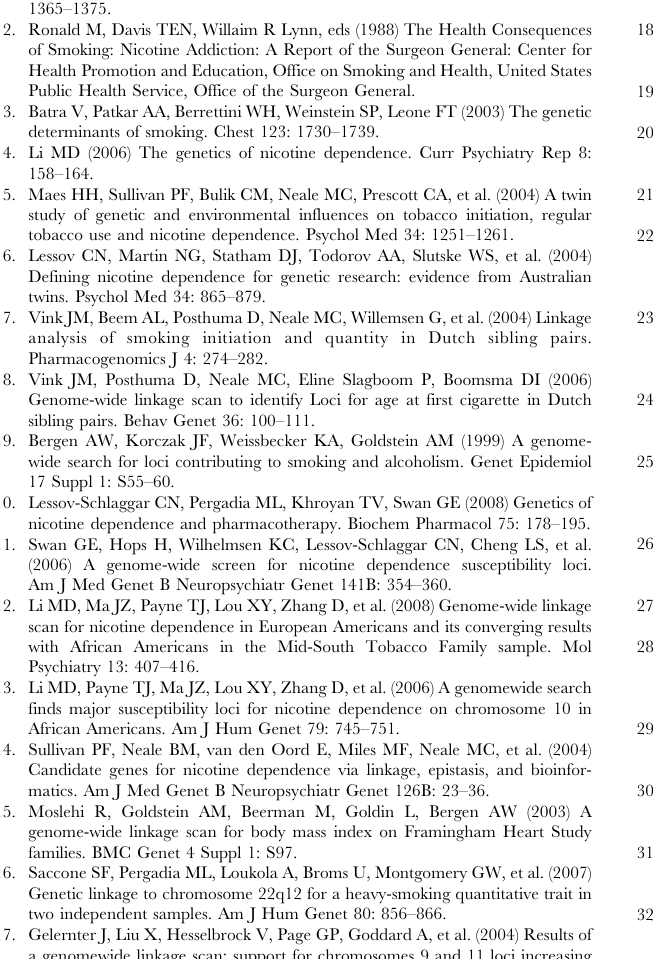
Found at: doi:10.1371/journal.pone.0004653.s002 (0.03 MB